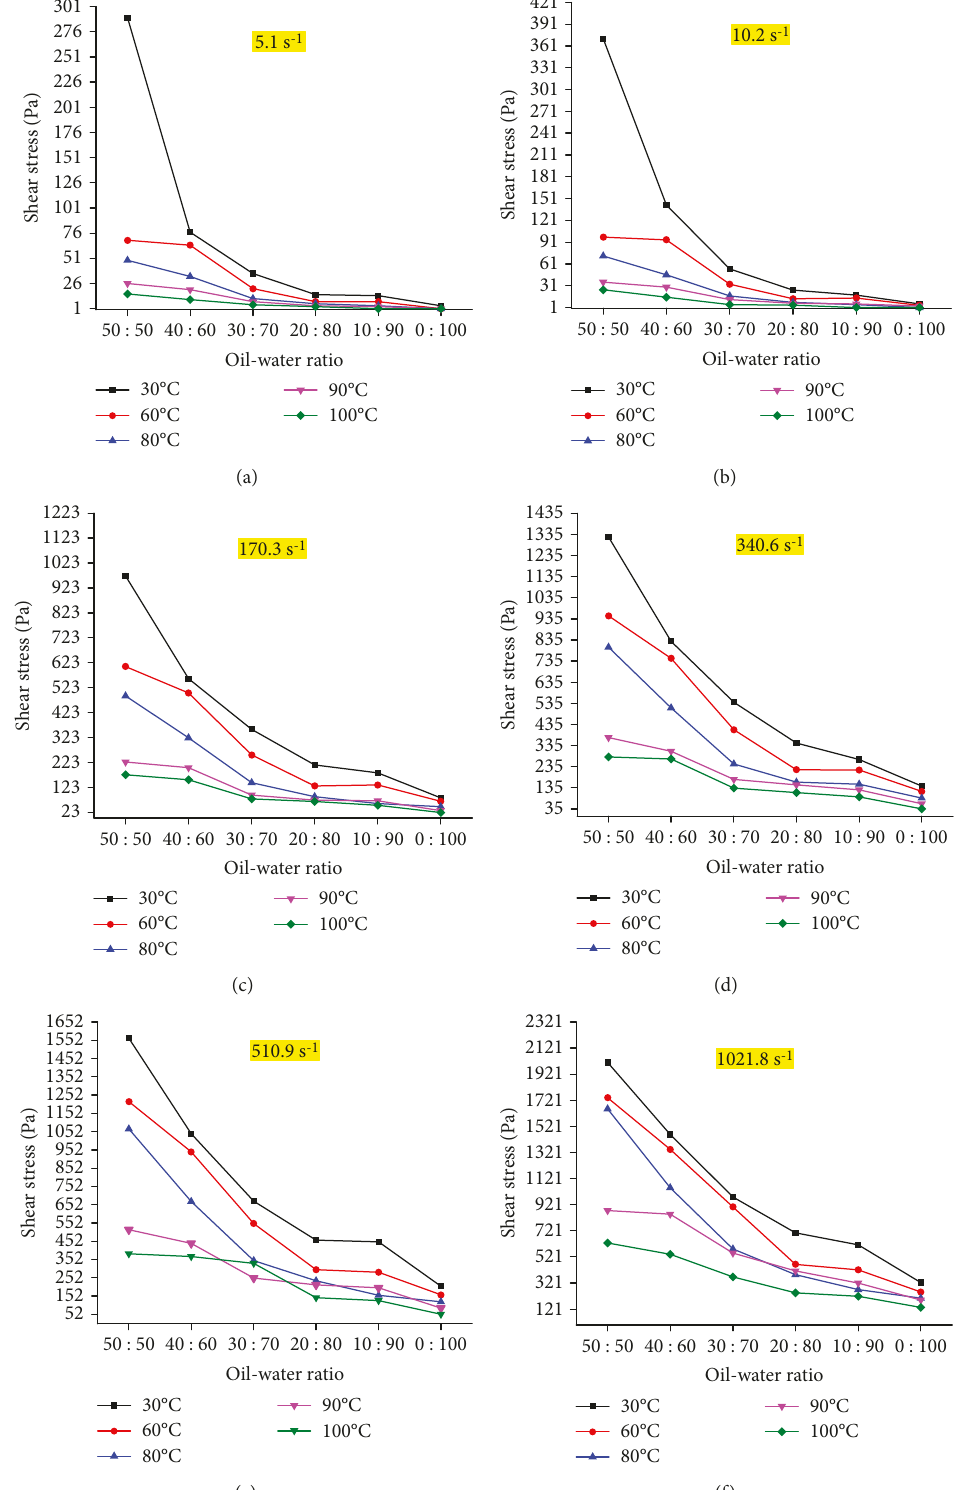
Figure 3: The relationship between the oil-water ratio and shear stress at di ff erent shear